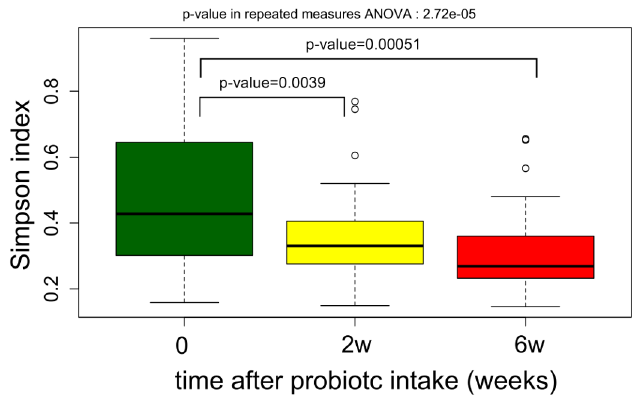
Fig 5. Boxplot of community α diversity expressed by the Simpson index in stool samples collected from preterm infants at day 0 (prior to supplementation), and 2 (2w) and 6 (6w) weeks following probiotic or placebo supplementation. P-values on the figure are p-values obtained by the pairwise t-test, adjusted for multiple testing by the Benjamini – Hochberg procedure.